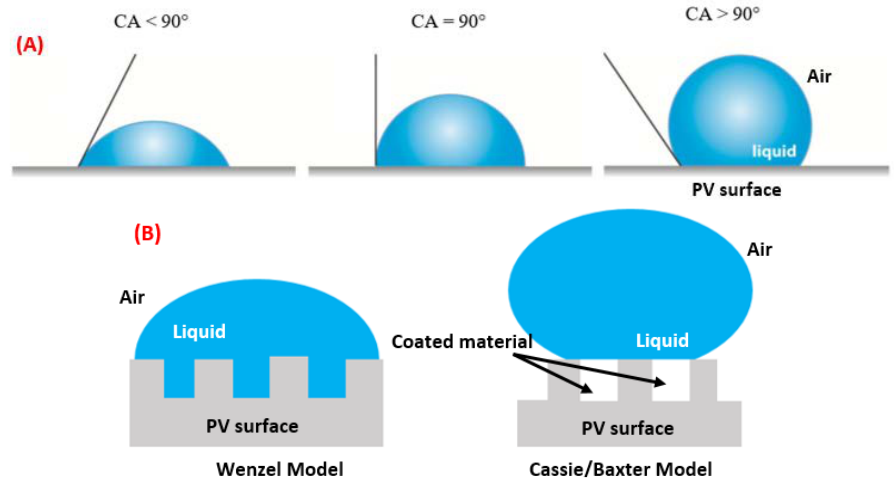
Figure 4. Behavior of a water droplet on a hydrophobic surface. ( A ) Water contact angles (CA) and ( B ) Wenzel and Cassie/Baxter models.